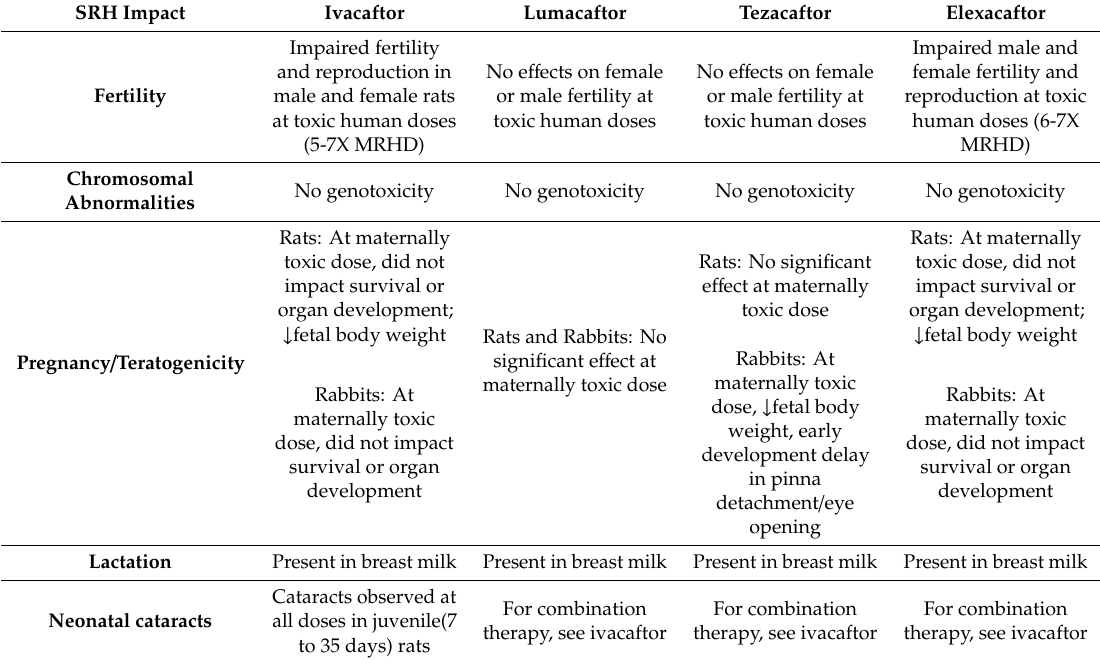
Table 1. Data from animal reproduction models investigating the impact of CFTR modulator administration on sexual and reproductive health